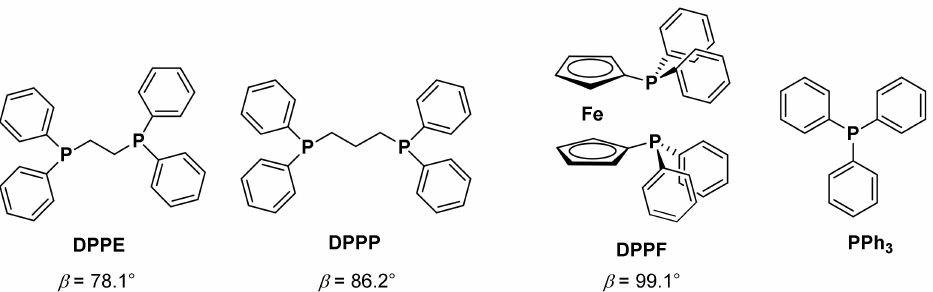
Figure 1. Phosphine ligands evaluated in this study for one-pot methoxycarbonylation reactions. Natural bite angle ( β ) reported are taken from ref.